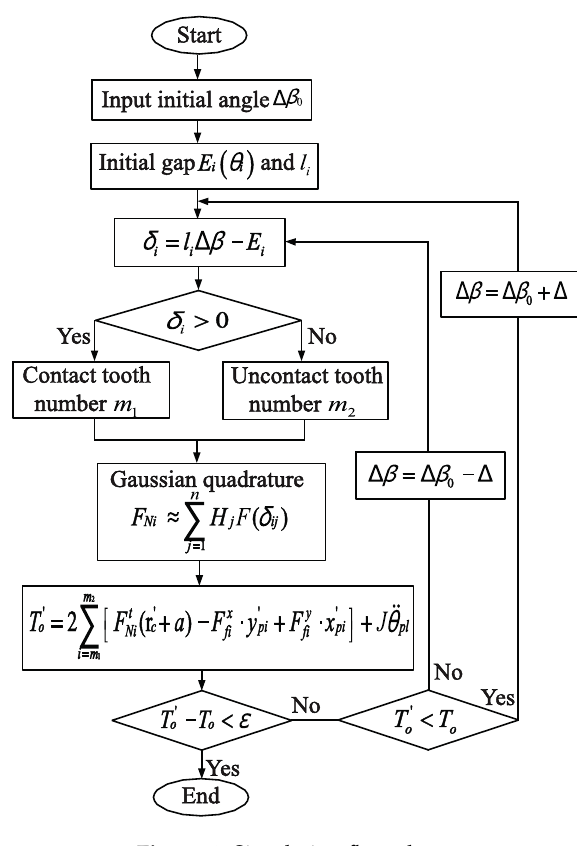
Figure 4. Simulation flow chart.